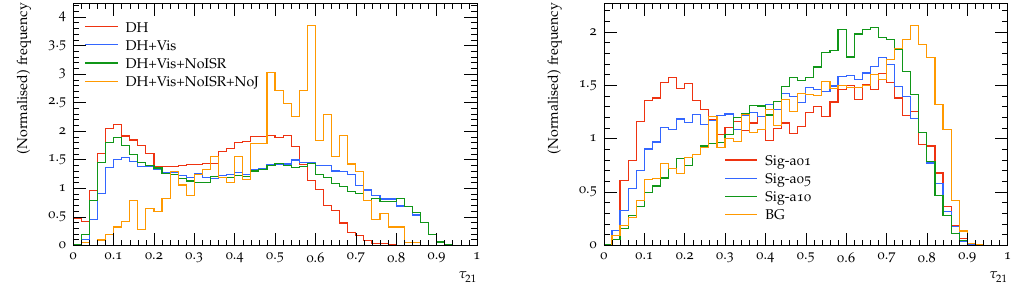
Figure 10: Comparisons of τ signals corresponding to clustering only with dark hadrons, adding visible hadrons, tuning ISR off, and also turning extra ME jets off with R different signals corresponding to α